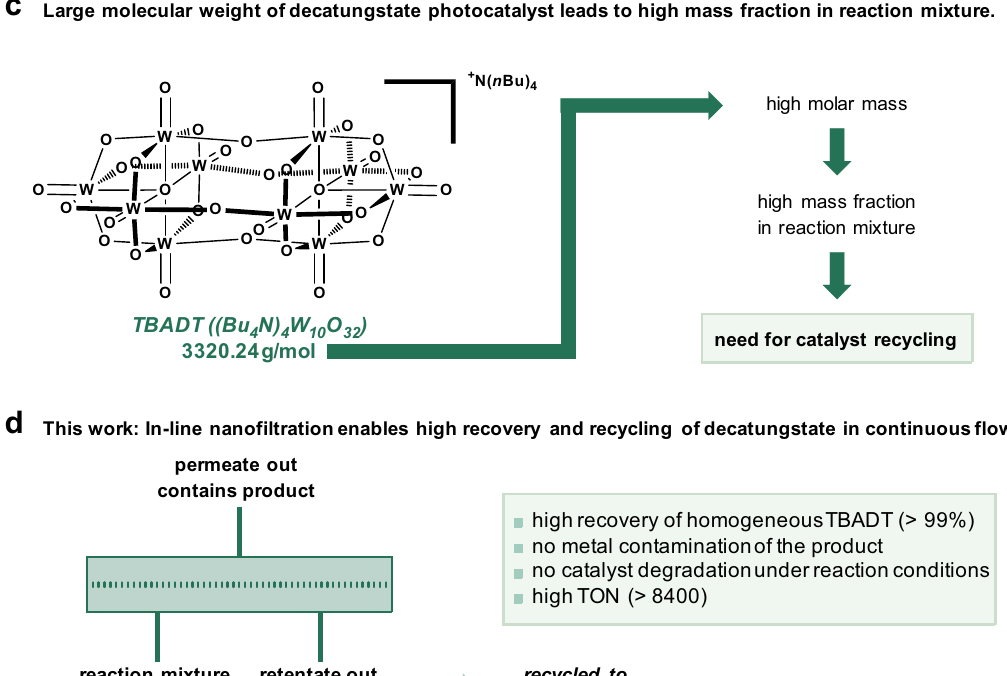
Medicinal chemistry versus process chemistry: a challenging, time-constrained transition.